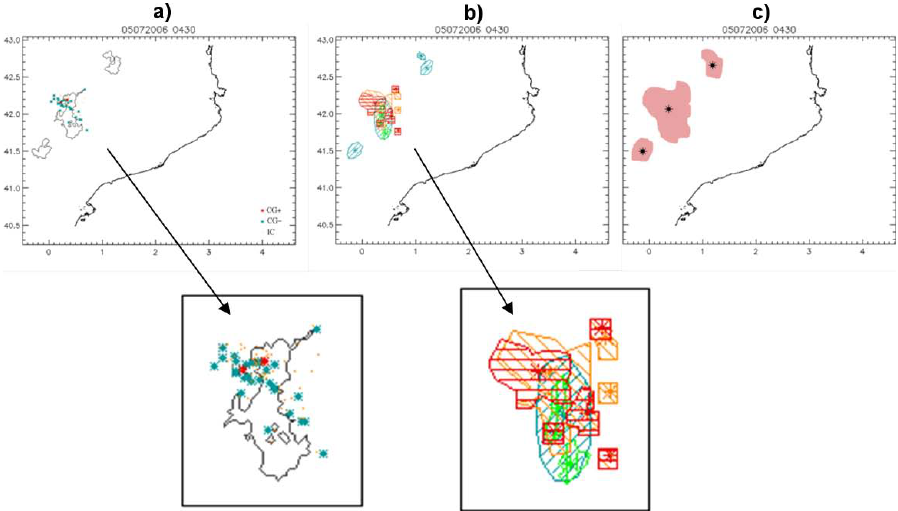
Fig. 3. Example of object identification methodology (same date and time as Fig. 2). (a) Radar reflectivity areas exceeding 12dBZ are indicated by thin black lines overlayed to +CG (red asterisks), − CG (blue asterisks), and IC flashes (red dots). (b) RAD2 (blue), RAD3 (green), XDC (orange), and XDG (red) first level objects. (c) Thunderstorm structures and their centroids after combining the first level objects shown in (b). Bottom row shows zooms of (a) and